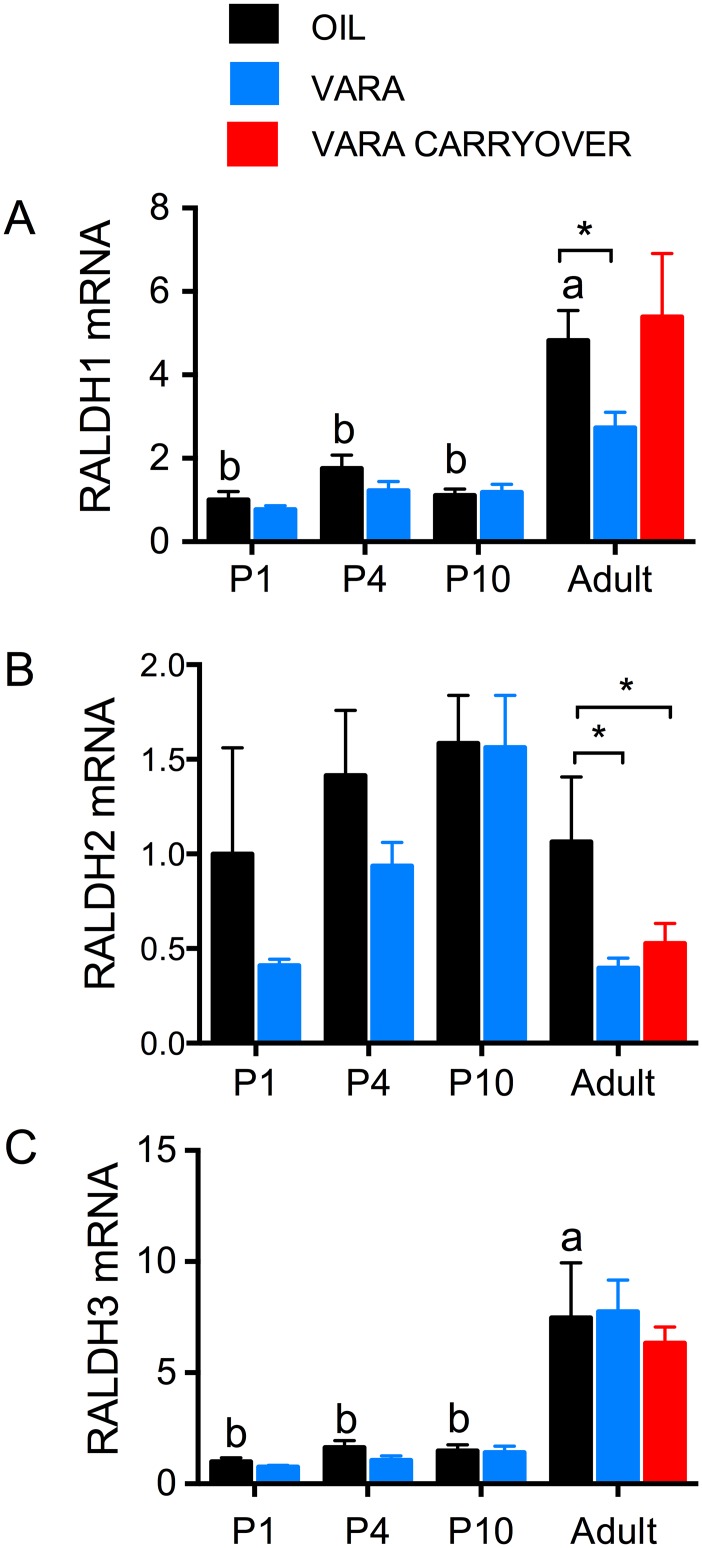
Expression of retinoid biosynthetic genes in lungs of neonatal rats and adult-age rats fed VAM diet and treated with or without VARA.Relative levels of mRNA transcripts are shown for Raldh-1 (A), Raldh-2 (B) and Raldh-3 (C) in lung, under experimental conditions described in Fig 1A. Data are shown as mean ± SEM, n ≥ 5/group. One-way ANOVA with post-hoc analysis was used to determine differences between oil-treated groups at different ages, indicative of differences due to ontogeny. Means without a common letter differ significantly, P < 0.05. For each age, VARA versus Oil groups were compared by t-test; * indicates P < 0.05. Abbreviations: P, postnatal day; VARA, vitamin A combined with 10% retinoic acid; Raldh, retinaldehyde dehydrogenase.